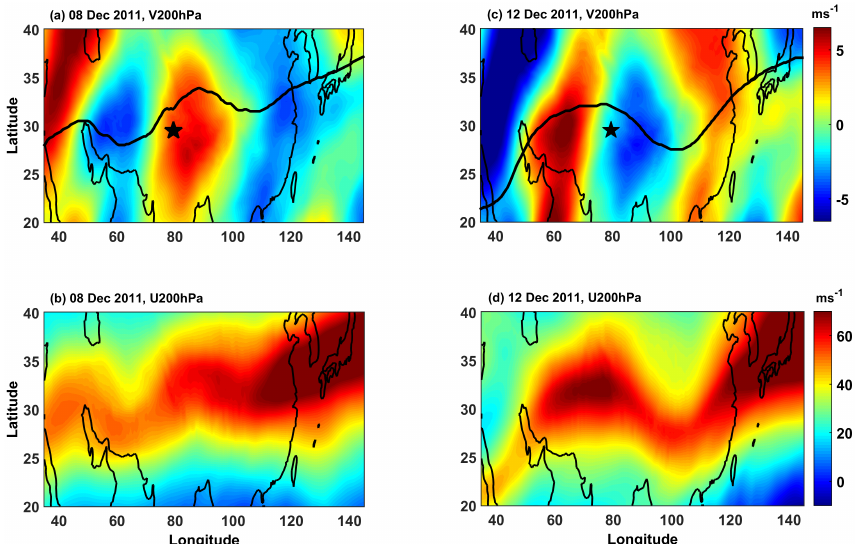
Figure 5. Meridional wind anomalies (a) at 200hPa pressure level ( v 200hPa) overlaid with the position of subtropical jet stream (thick solid black line) and zonal wind (b) at 200hPa pressure level on 8 December 2011 obtained from MERRA reanalysis. (c) and (d) Same as (a) and (b) except on 12 December 2011. The location of ARIES, Nainital (29.45 ◦ N, 79.5 ◦ E), is also indicated by the star in (a) and (c)